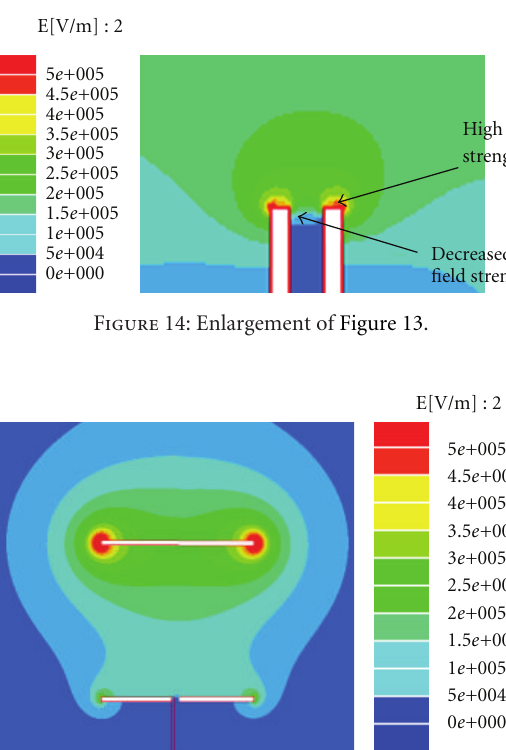
Figure 15: Comparison of bottom plates with (right) and without (left) a hole cut in.